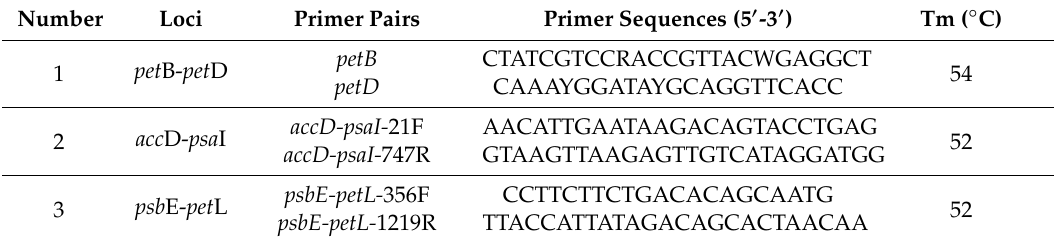
Table 3. Information of 3 chloroplast DNA sequence (cpDNA) primers used in 80